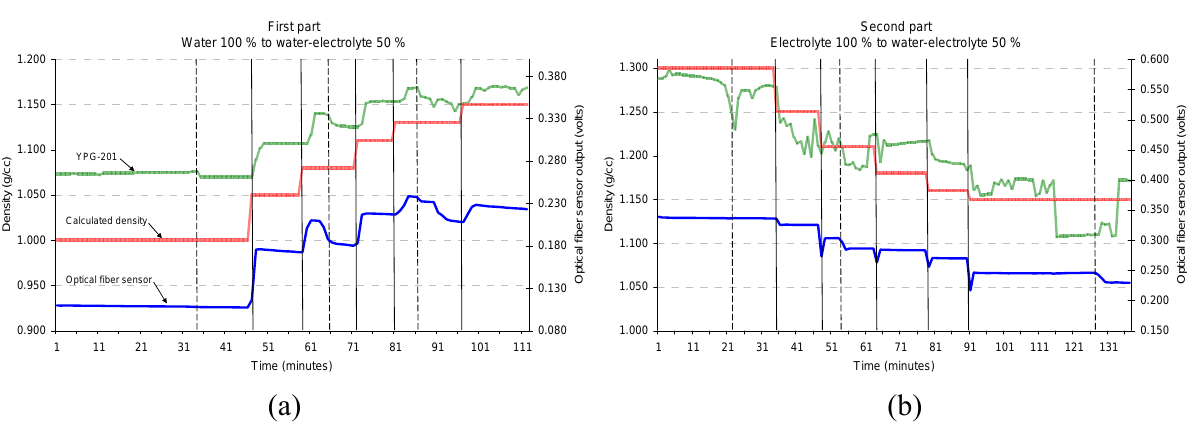
Figure 12. Behavior of the optical fiber sensor in solutions of electrolyte and water. (a) Water 100% to water-electrolyte 50%. (b) Electrolyte 100% to water –electrolyte 50%.